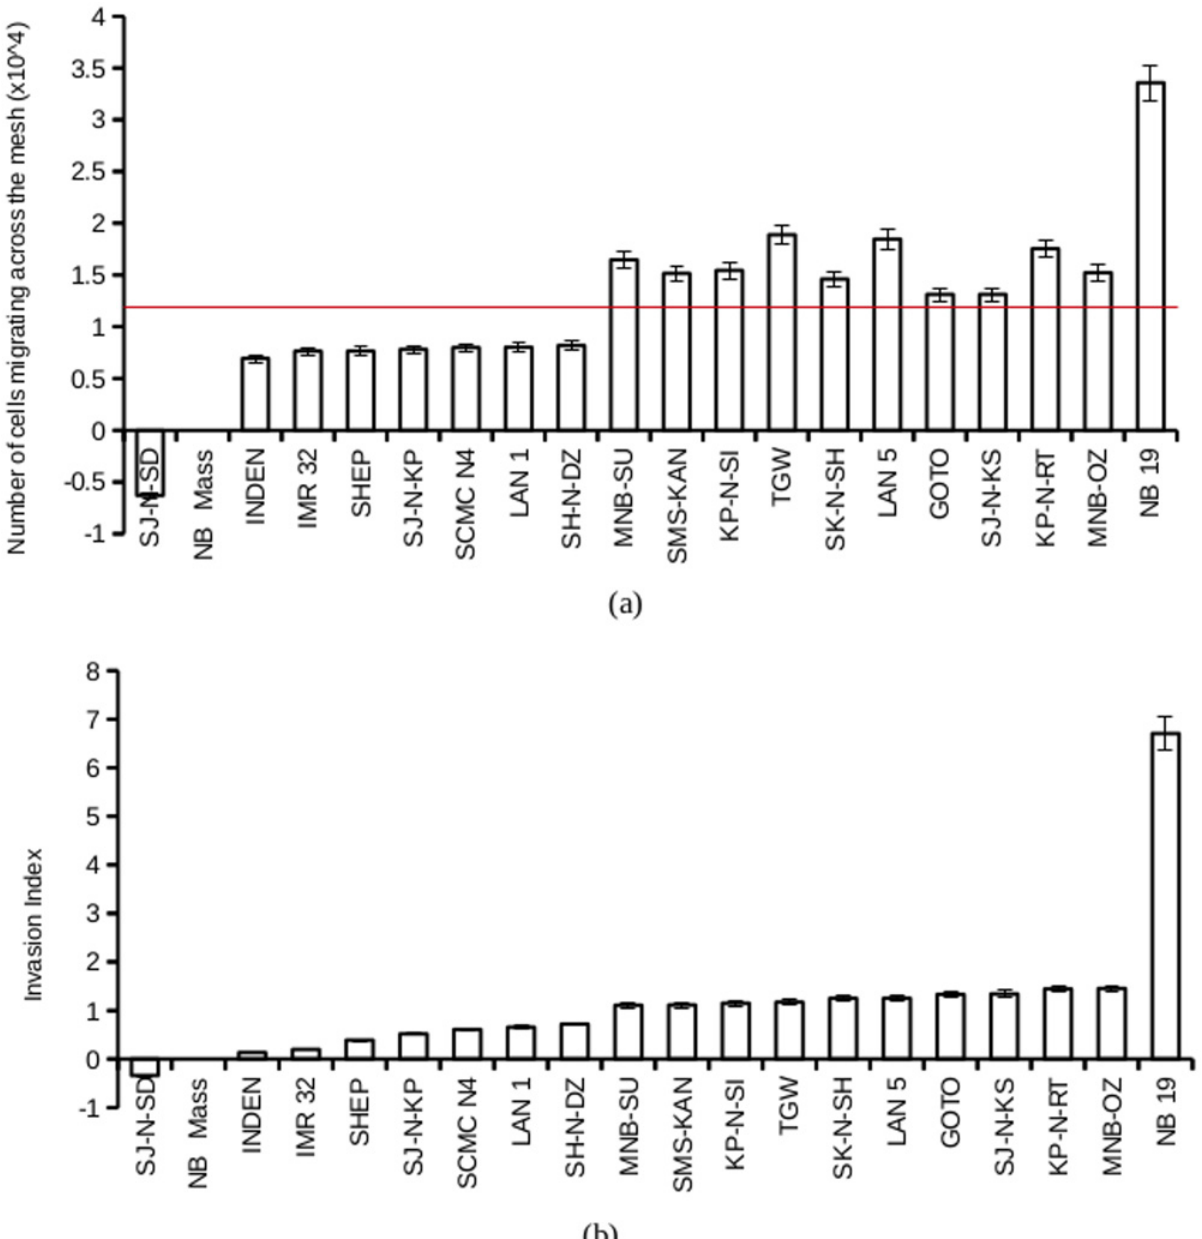
Fig 1. Invasive potential of neuroblastoma cell lines. a. 20 neuroblastoma cell lines were serum-starved for 24 hours, and plated at a seeding density of 0.5 X 10 5 cells per well on to 0.8 micron cell culture inserts, coated with Basement Membrane Extract (BME) coat at 0.5x to 1x dilution. The number of cells crossing the mesh towards RPMI (control) or mRPMI were counted fluorimetrically using calcein AM after 12 hours. Plotted is the average number of cells, for each cell line from 7 experiments, migrating across the mesh. The red line indicates the mean value. Cell lines higher than the mean value were classified as highly invasive and those below the mean value as less invasive cell lines. b. Invasion index was calculated as the ratio of number of cells invading towards mRPMI versus the number of cells invading towards RPMI. Plotted is the mean invasion index from 7 experiments in increasing order. Cell lines with an invasion index of 1 or higher was classified as highly invasive cell lines and those with an invasion index of less than 1 was classified as less invasive.